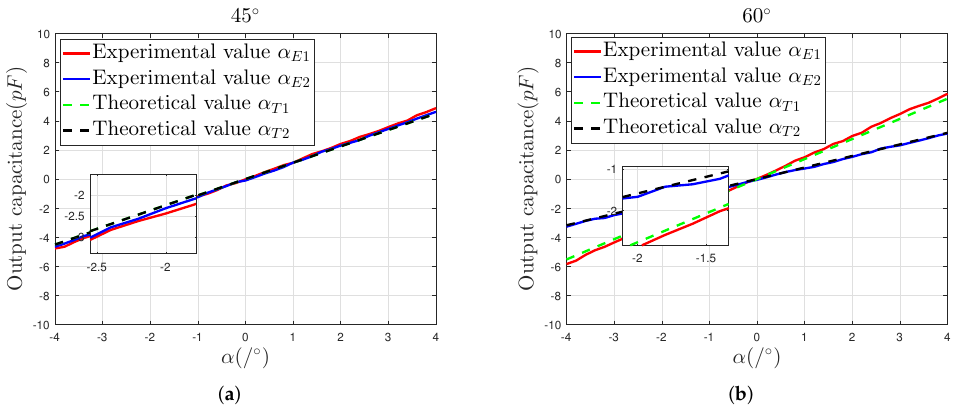
Figure 10. Comparison of experimental and simulation values of the output capacitance: ( a ) the output capacitance in the direction of 45 ◦ , ( b ) the output capacitance in the direction of 60 ◦ . It also can be seen from Figure 10 that, compared with the solution value of α 1 , the solution value of α 2 is closer to the theoretical data. In the 45 ◦ direction, the maximum measurement error of α 1 is 0.39 pF, and the maximum measurement error of α 2 is 0.18 pF. In the 60 ◦ direction, the maximum measurement error of α 1 is 0.38 pF, and the maximum error of α 2 is 0.13 pF. In different directions, the deviation between the slope of the α E 1 curve